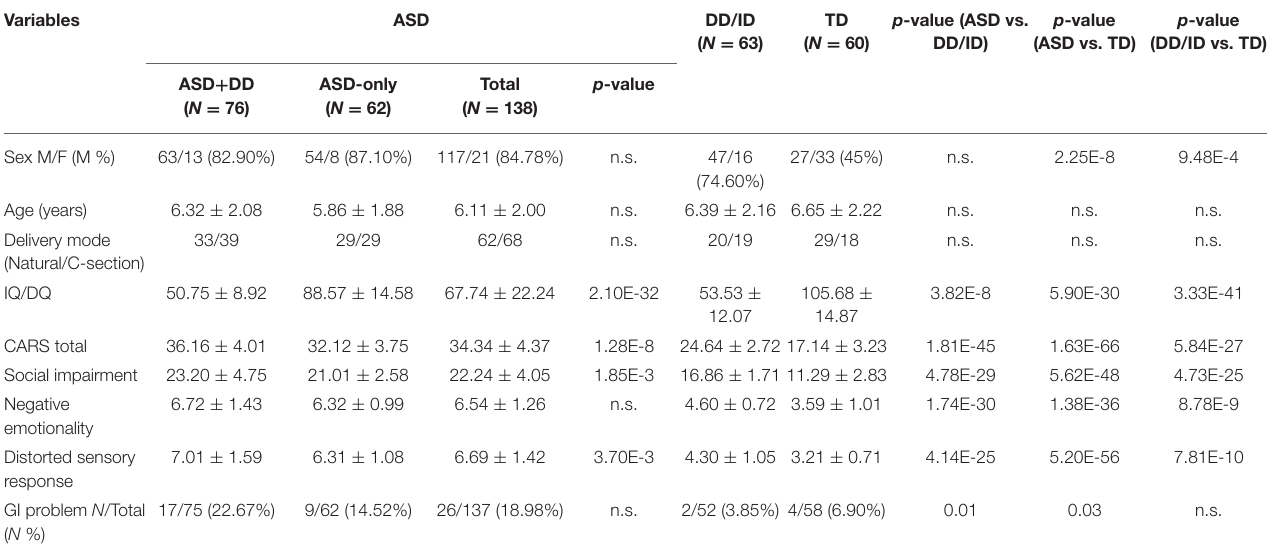
TABLE 1 | Characteristics of ASD, DD/ID, and